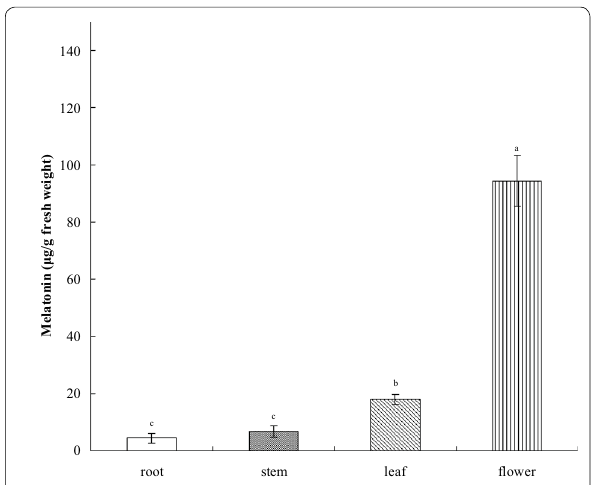
Fig. 2 Melatonin concentrations in various parts of H. perforatum L. Data are the mean of three replicates, and different letters represent significant differences at p < 0.05